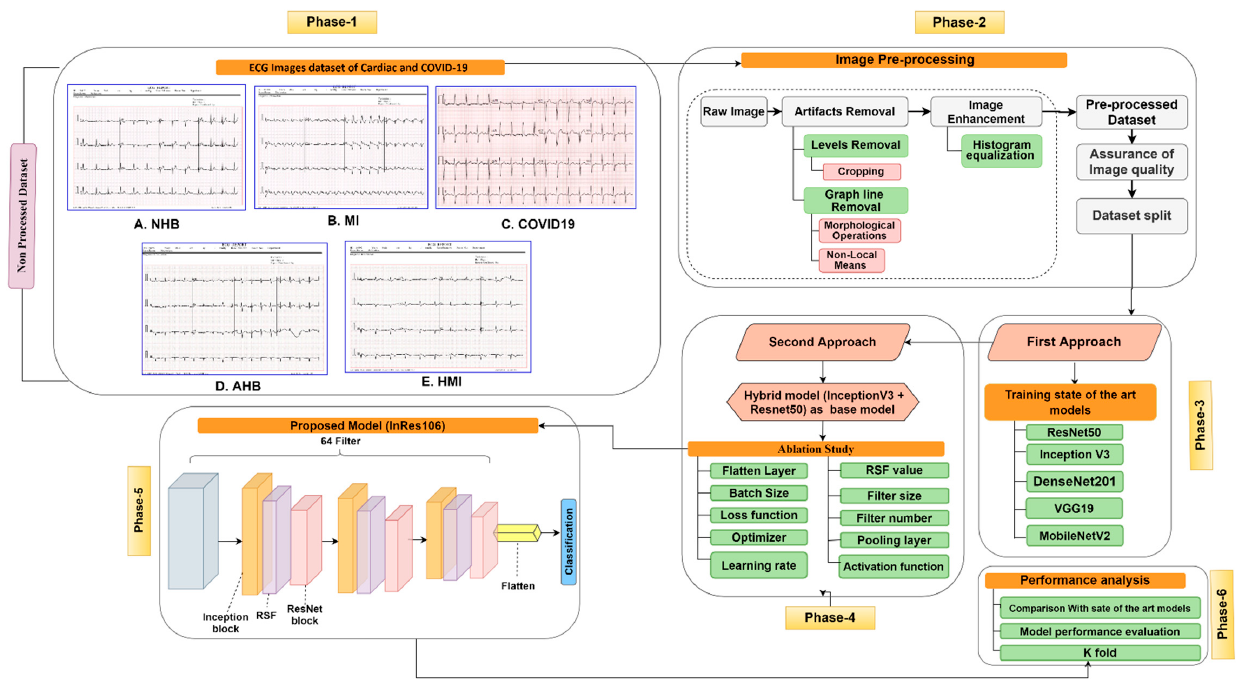
Figure 1. Flow diagram; Phase-1: Cardiac and COVID-19 image dataset, Phase-2: Image pre-pro- cessing (Raw image, Artifacts removal (labels removal, graph line removal), and image enhance- ment (HE), assurance of image quality, dataset split), Phase-3: First approach: Applying five transfer